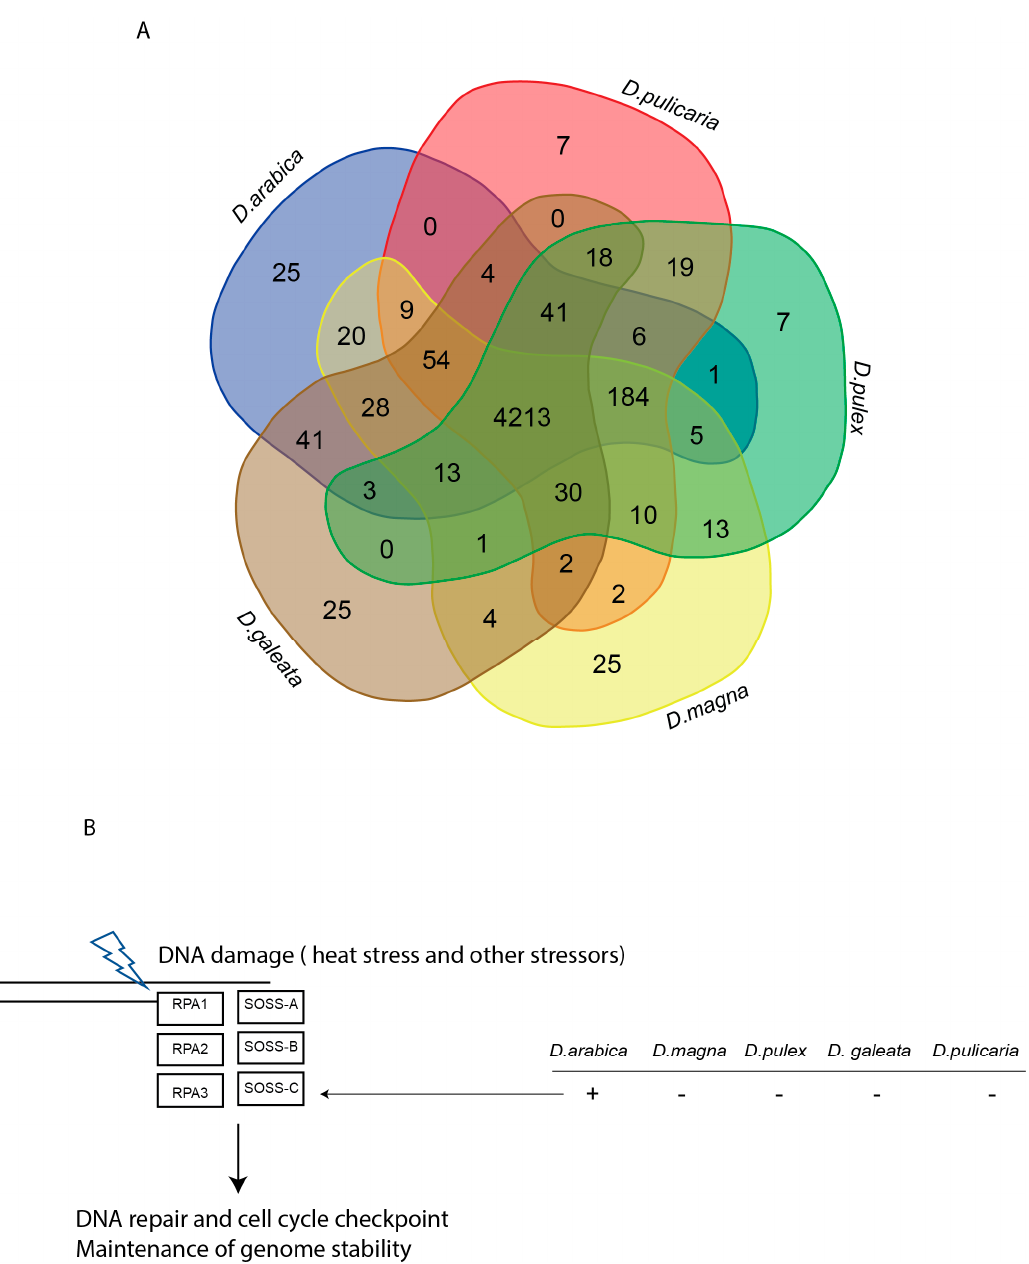
Figure 4. Comparative analysis based on the Daphnia gene families. ( A ) Venn diagram shows the distribution of PFam gene families between five Daphnia species ( D. arabica, D. pulicaria, D. pulex, D. magna and D. galeata). ( B ) Comparison of SOSS-C in D. arabica, D. pulicaria, D. pulex, D. magna, and D. galeata